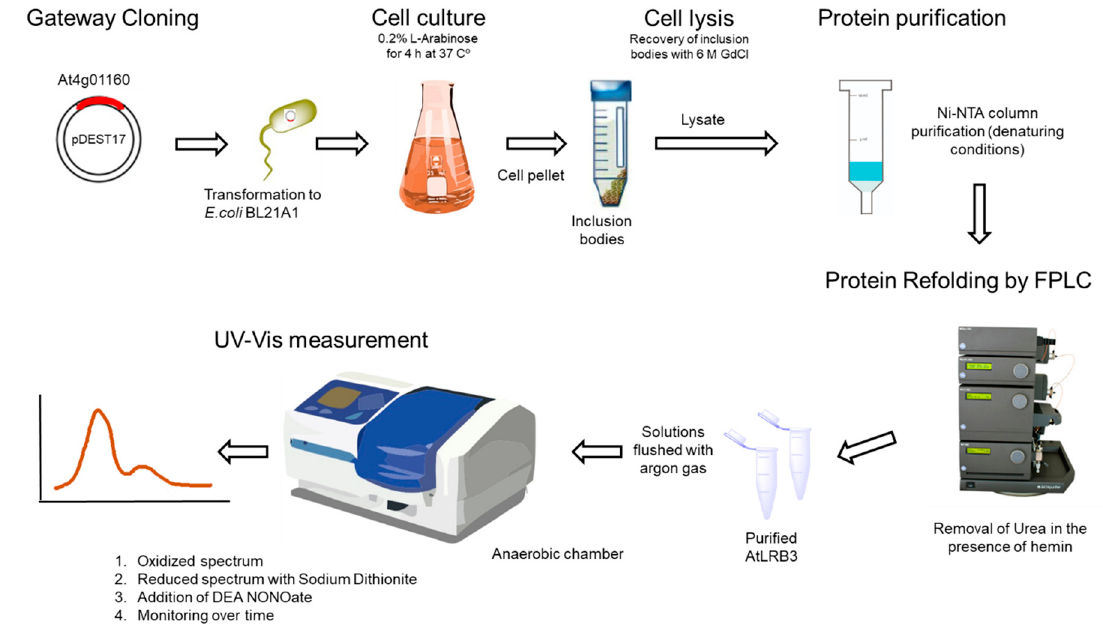
Figure 5. Flowchart for the generation of recombinant Light Response Bric-a-Brac/Tramtrack/Broad Complex (AtLRB3) proteins.